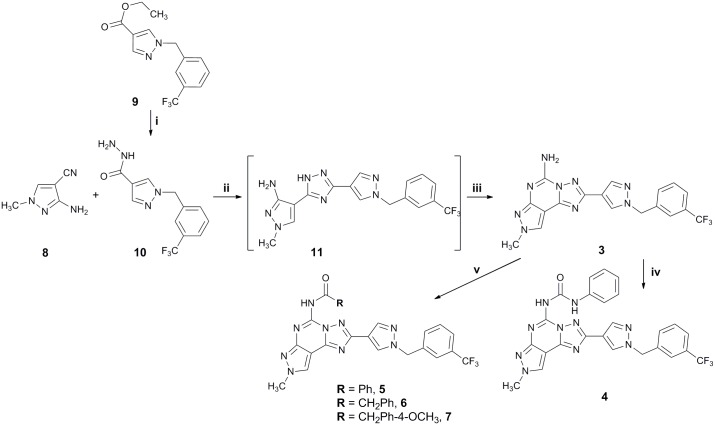
Synthesis of desired compounds 3–7.
Reagents: i: NH2NH2
.H2O, EtOH, reflux, 3 days; ii: Ph2O, 260°C, 2.5 h; iii: NH2CN, pTsOH, 160°C, 4 h; iv: PhNCO, dioxane, reflux; v: RCOCl, Et3N, dioxane, reflux.